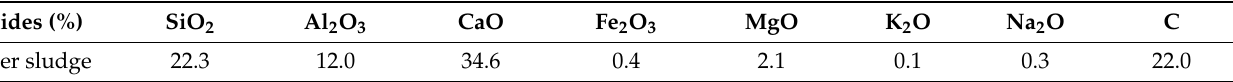
Table 11. Oxide composition of paper